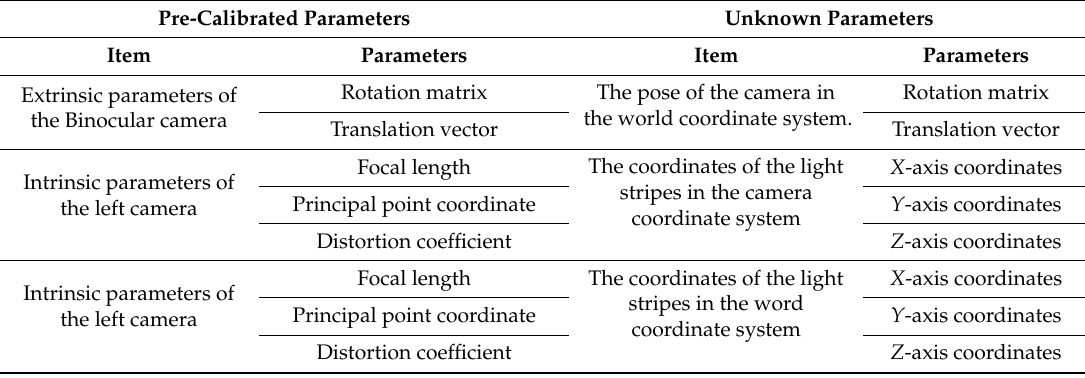
Table 1. The pre-calibrated variables and the variables to be